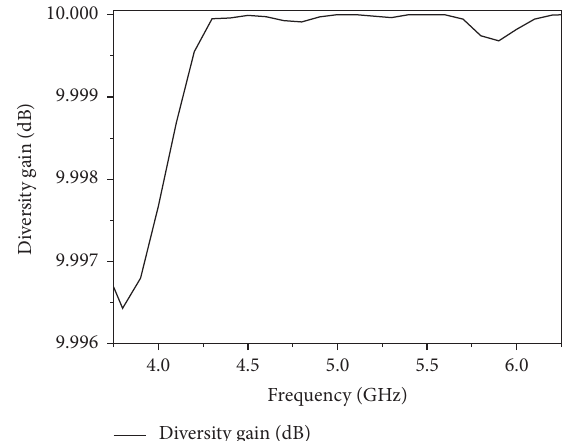
Figure 16: Computed diversity gain (DG) of the proposed MIMO